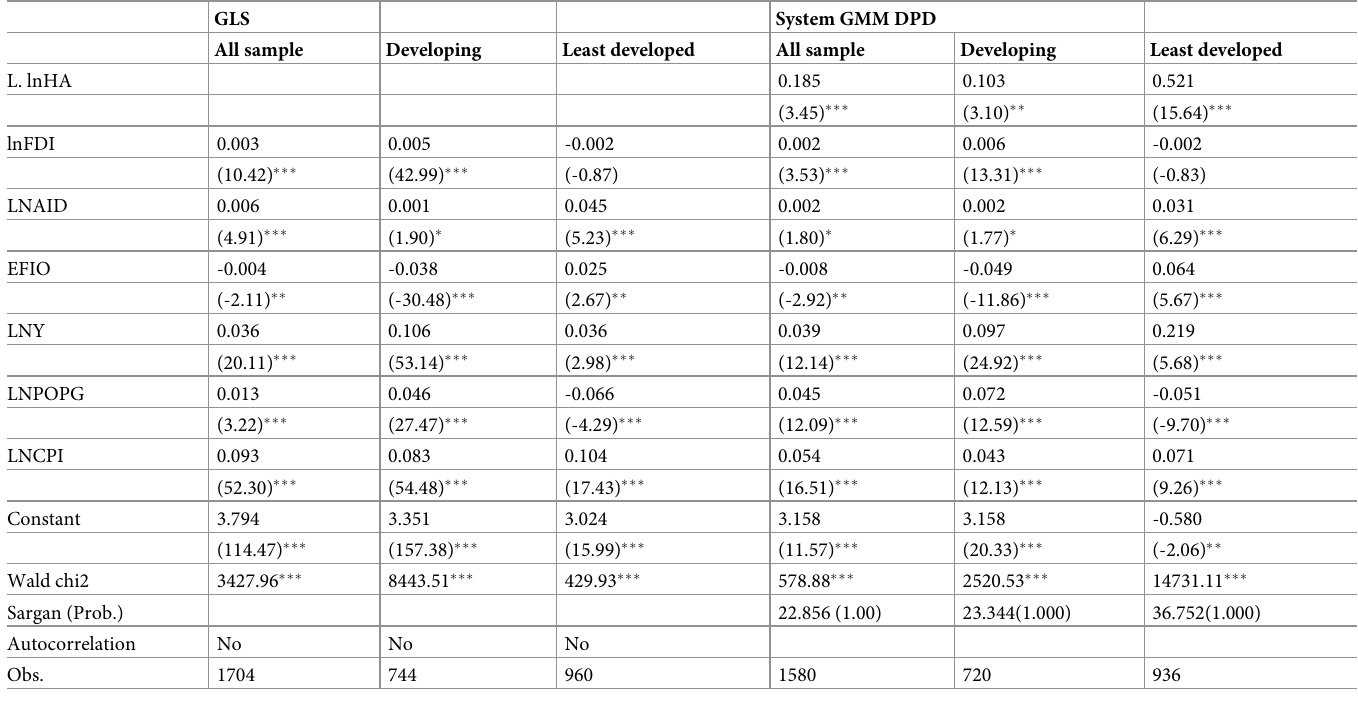
Table 6. Long-run estimations (Source: Authors’ own estimations). GLS System GMM DPD All sample Developing Least